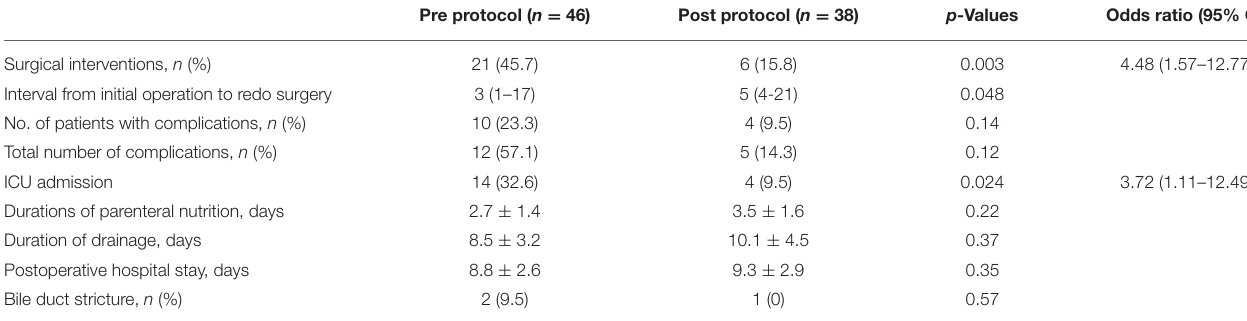
TABLE 2 | Outcome characteristics in comparison between Pre and Post protocol